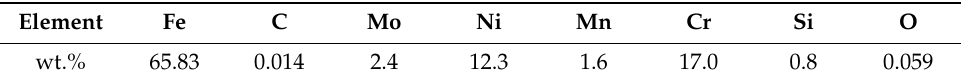
Table 2. Chemical composition and of 316L alloy powder from Table 1. Element Fe C Mo Ni Mn Cr Si O wt.% 65.83 0.014 2.4 12.3 1.6 17.0 0.8